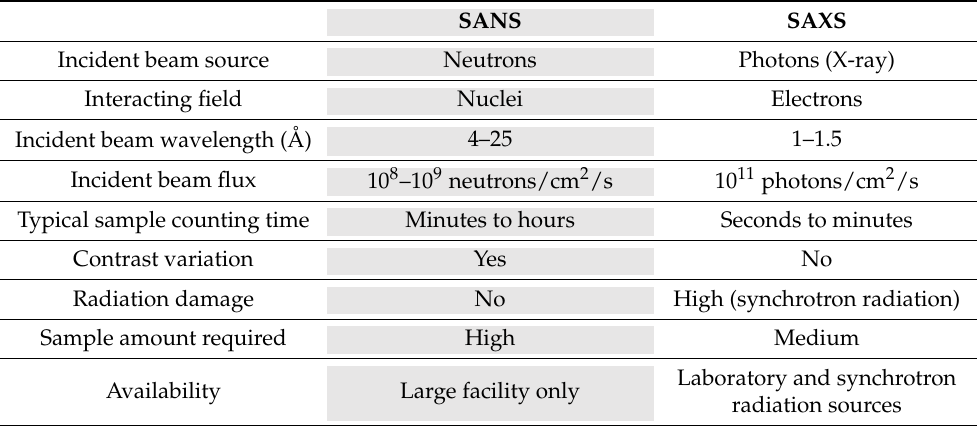
Table 1. Practical comparison of small-angle neutron and X-ray scattering (SANS and SAXS, respec- tively) methods (information is taken from [36]). For ease of inspection, the SANS entries are shown with light grey background. SANS SAXS Incident beam source Neutrons Photons